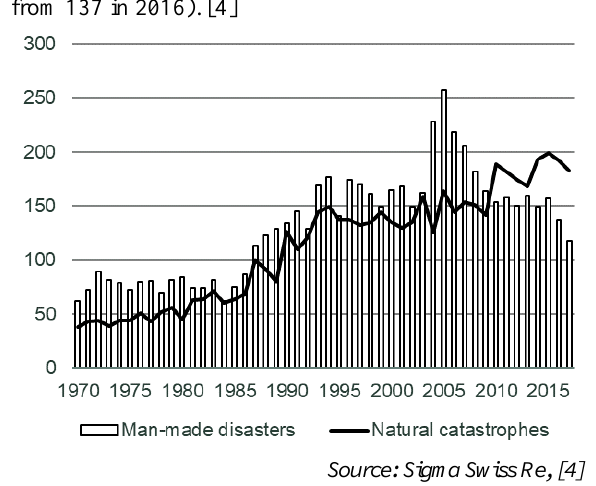
Fig. 1. Number of catastrophic events, 1970-2017